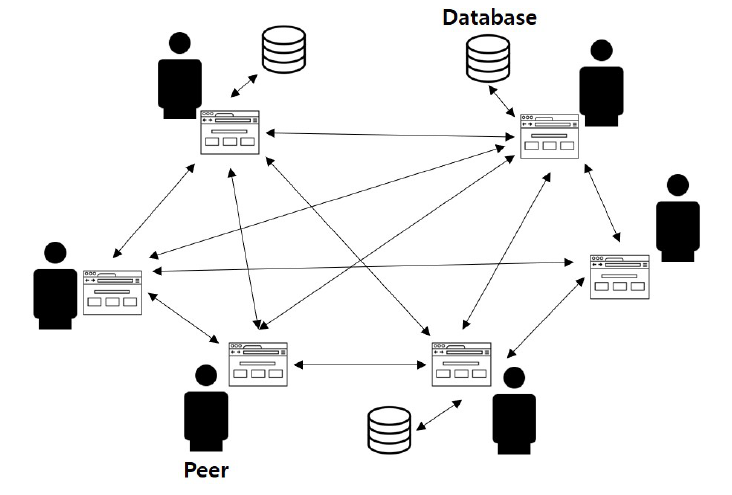
Figure 6. Structure of the decentralized blockchain-based